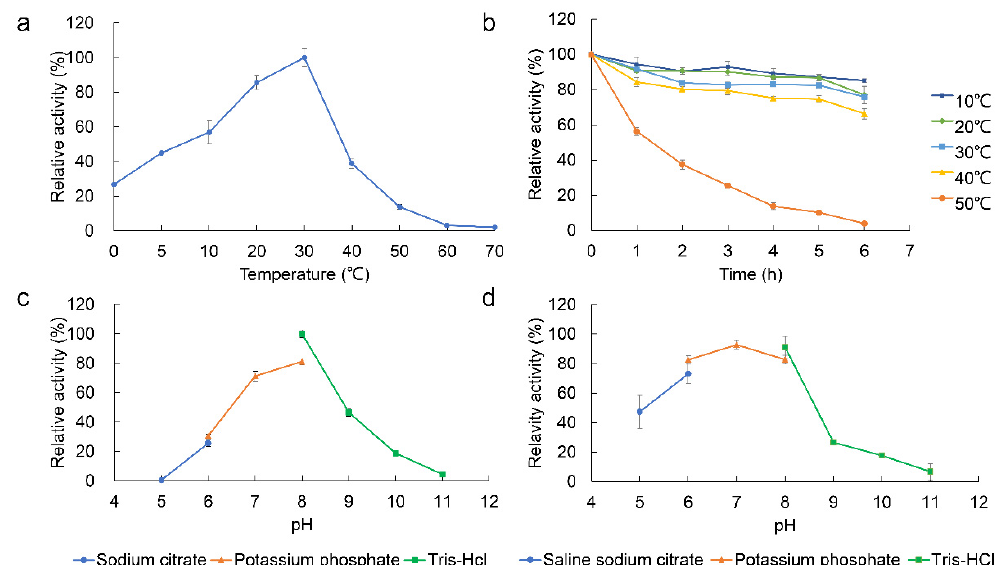
Figure 4. Effect of temperature and pH on enzyme activity. ( a ) Effect of temperature on esterase activity using pNPC8 as a substrate from 0–70 °C. ( b ) Temperature stability of EstDR4 at various temperatures (10 °C, 20 °C, 30 °C, 40 °C and 50 °C) for 1 to 6 h with esterase activity assayed every hour at 30 °C and pH 8. ( c ) Effect of pH on enzymatic activity, measured from pH 5–11. ( d ) Stability of EstDR4 at different pH values (pH 5–11) for 1 h at 30 °C followed by esterase activity assayed at 30 °C and pH 8. All-results are shown in relative activity, the maximum activity measured was taken as 100%.